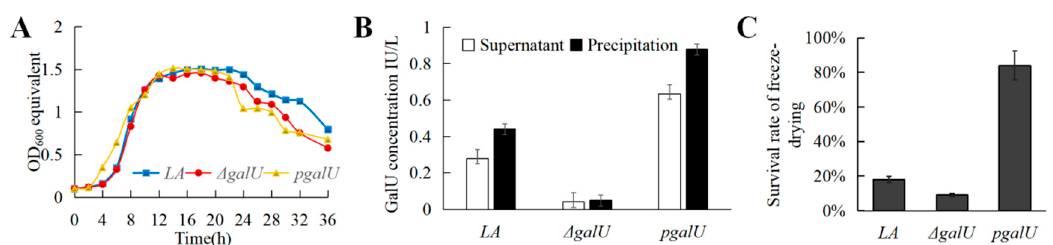
Figure 3. Growth curves, GalU enzyme activity and freeze-drying survival rate for strains LA, ∆ galU and pgalU. ( A ) Growth curves of strains LA, ∆ galU and p galU . ( B ) GalU enzyme activity in strains LA, ∆ galU , and p galU . ( C ) The freeze-drying survival rate for strains LA, ∆ galU, and p galU